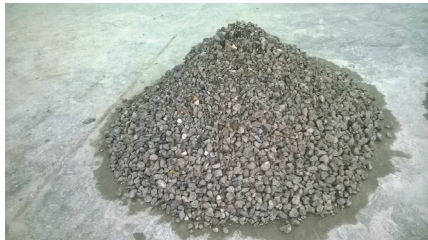
Figure 2: Stack of recycled aggregate to be used in fresh concrete.